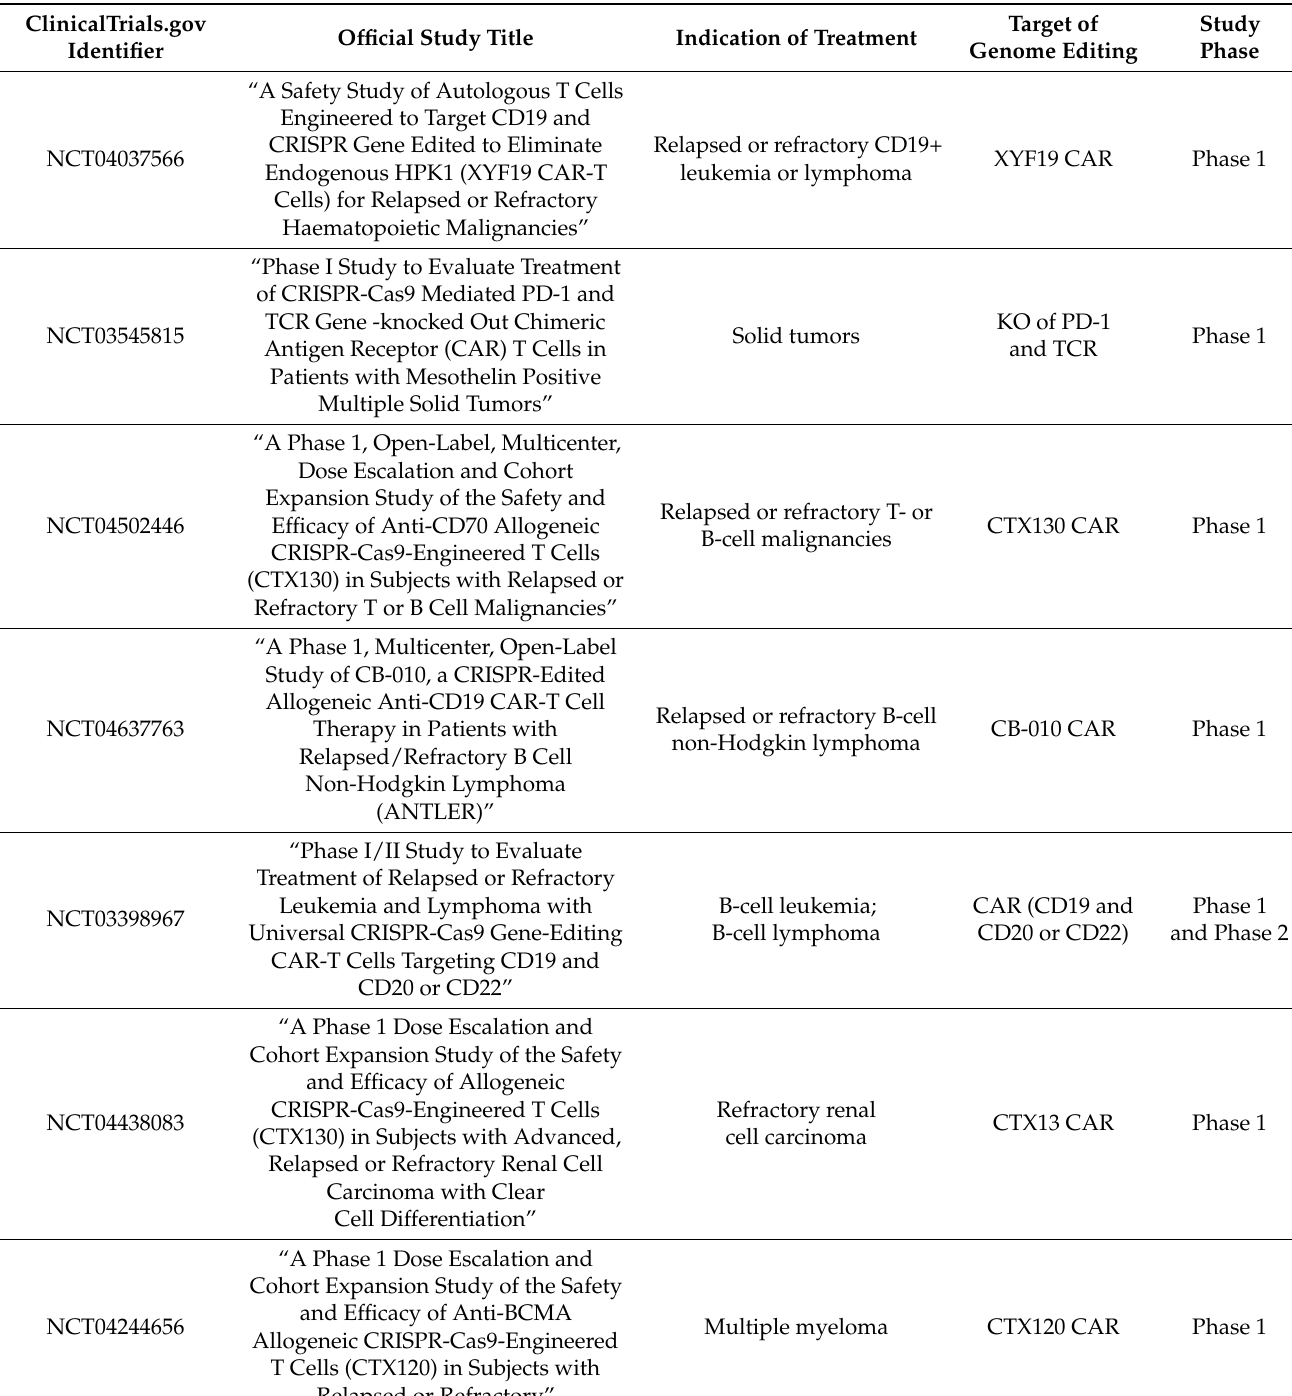
Table 1. Overview of currently ongoing clinical studies with CRISPR-engineered T cells (last time accessed on 21 December